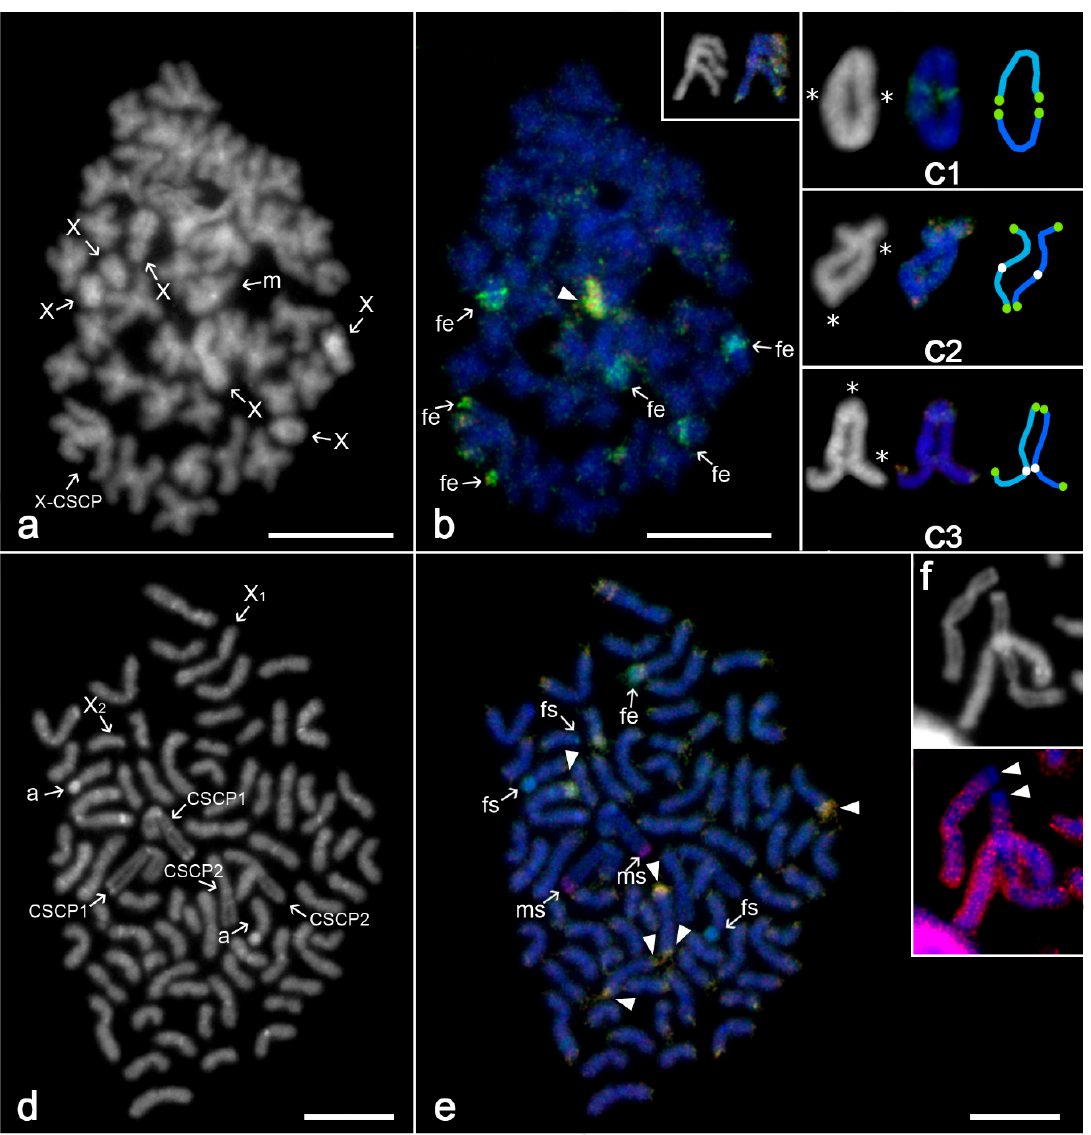
Figure 1. Comparative genomic hybridisation, mygalomorphs Linothele megatheloides ( a – c ) and Grammostola aff. porteri ( d – f ), male plates. Abbreviations and symbols: fs—female specific signal (green), fe—female enriched (i.e., biased accumulation of female probe; greenish), ms—male specific signal (red), arrowhead—region highlighted by both male and female probe. ( a , b ) L. megatheloides . One sister metaphase II including eX chromosome of cryptic sex chromosome pair (CSCP; X-CSCP) and multiple X chromosomes (differing by a tight attachment of chromatids): ( a ) DAPI counterstaining (m—metacentric autosome). Some autosomal centromeres form tiny AT-rich regions; ( b ) comparative genomic hybridisation (CGH). Predominant accumulation of female probe: regions on four X chromosomes, one end of X-CSCP chromosome. Highlighted by both male and female probe: terminal block of a metacentric autosome. Inset: Y chromosome of CSCP, another metaphase II (left DAPI counterstaining, right CGH): the hybridisation pattern resembled the one of X-CSCP; ( c ) L. megatheloides , metaphase I, CSCP, pattern of chiasmata [left DAPI counterstaining, asterisk—chiasma; right CGH and schematic drawing of bivalent (one homolog blue and another one light blue, green spots—female-biased signals at the end of chromosomes, white spots—centromeres)]. CSCP includes two chiasmata, which display pericentric ( c3 ), intercalar ( c2 ) or distal location ( c1 – 3 ). ( d – f ) Grammostola , mitotic metaphase (a—chromosomes of an acrocentric pair; CSCP1—chromosome of metacentric CSCP; CSCP2—chromosome of submetacentric CSCP): ( d ) DAPI counterstaining. AT- rich regions: centromeres of some autosomes, centromere and a telomere block of metacentric CSCP; ( e ) CGH. Marked more intensely by female probe (greenish signals): one end of X 1 chromosome,